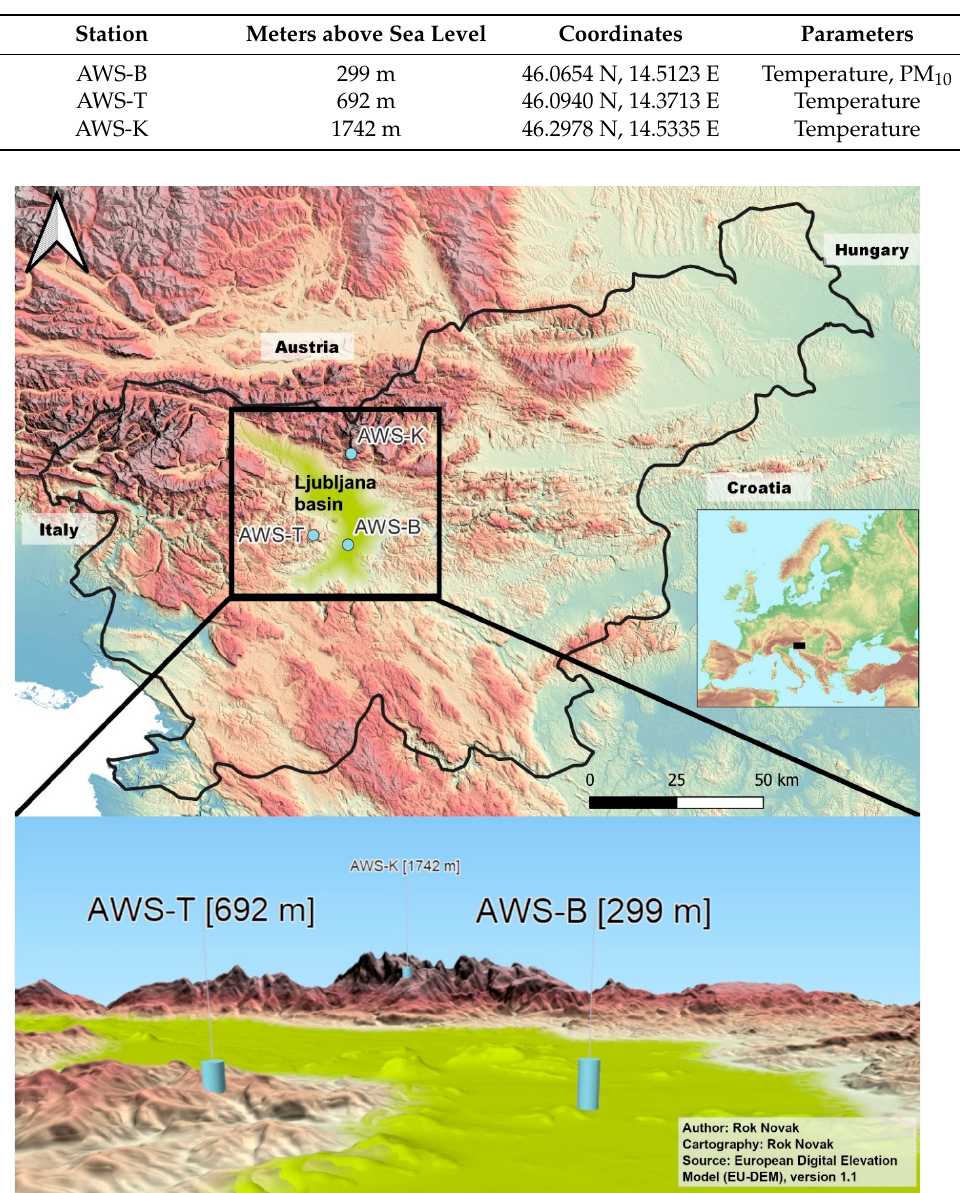
Figure 2. Geographical locations of automatic weather stations Bežigrad, Topol, and Krvavec. Top: Locations on a topographical map of Slovenia and neighboring countries with the location of the Ljubljana basin. Bottom: 3D visualization of locations and their respective elevations with vertical exaggeration (2), designed with the Qgis2threejs plugin [36] in QGIS 3.20.1-Odense [37].